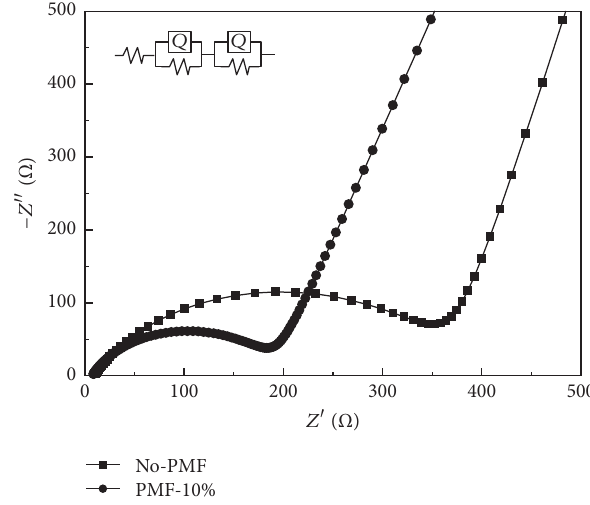
Figure 5: Cyclic voltammogram curves of prepared LiNi 0.5 Mn 1.5 O 4 .